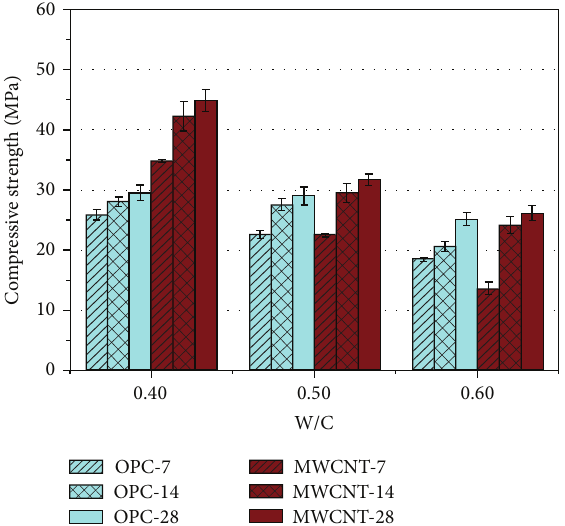
Figure 6: Compressive strength for various curing ages.